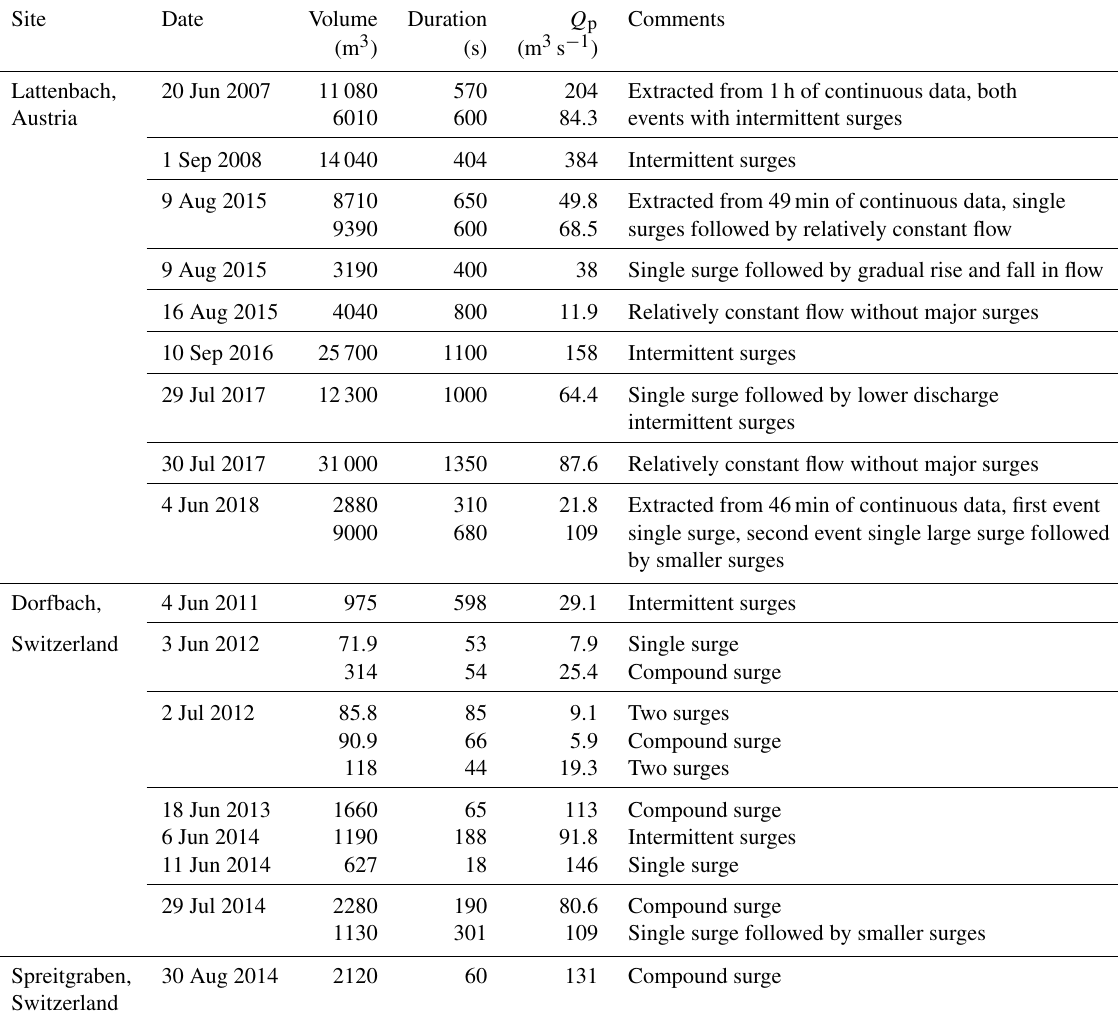
Table 1. Summary of hydrographs from monitored catchments at Lattenbach (Hübl and Kaitna, 2021) and Dorfbach and Spreitgraben (Jacquemart et al.,